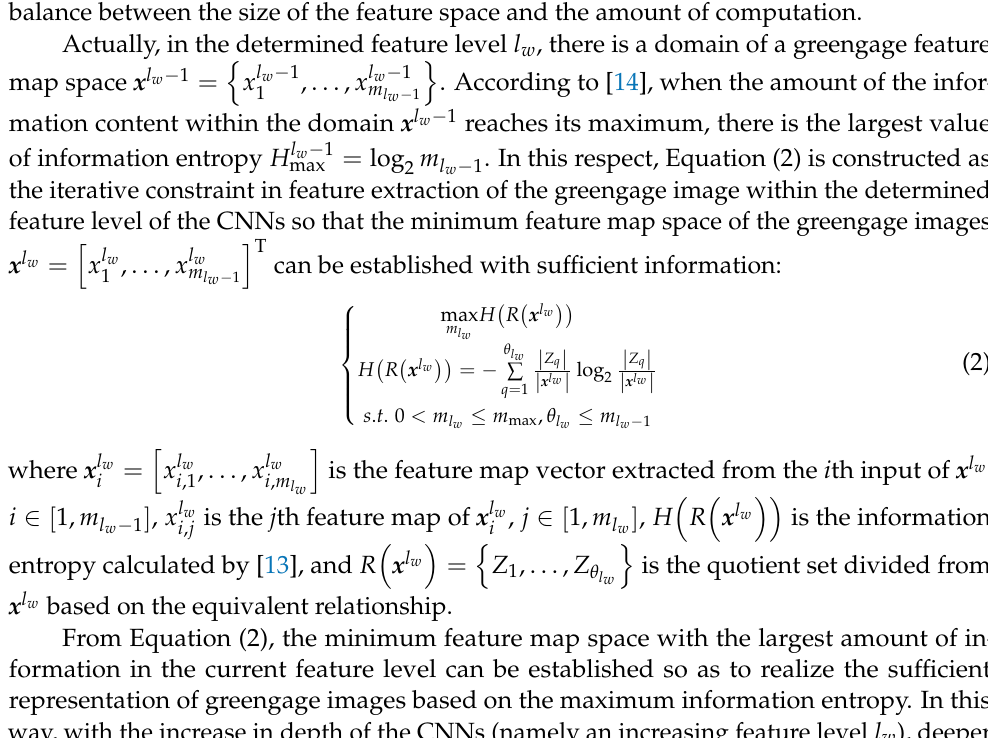
Figure 2. Structure of the convolutional feature extraction of a greengage image. In addition, based on a convolutional kernel with a size of 1 × 1, a convolution oper- ation is carried in the full connection layer 𝐹 𝐶 . By these means, the 𝐾 dimensional feature vector 𝐶 𝑖𝑙 𝑤 = {𝐶 𝑖,1𝑙 𝑤 , ⋯ , 𝐶 𝑖,𝐾𝑙 𝑤 } of 𝑈 𝑖 is obtained and sent to the following cognitive section, × 𝑣 𝑃 × 𝑚 𝑙 where 𝐾 = 𝑢 𝑃 is the dimension of the extracted feature vector. 𝑤 𝑙𝑤 𝑙𝑤 mapping from an input to an output can be realized with a convolutional kernel. In gen- eral, more feature maps will be obtained by increasing the convolutional kernels to repre- sent the image information from various perspectives. However, under the condition of a finite domain, increasing the feature dimensions will result in saturated information con- tent and an enormous increase in computational complexity. Therefore, it is necessary to seek a balance between the size of the feature space and the amount of computation.